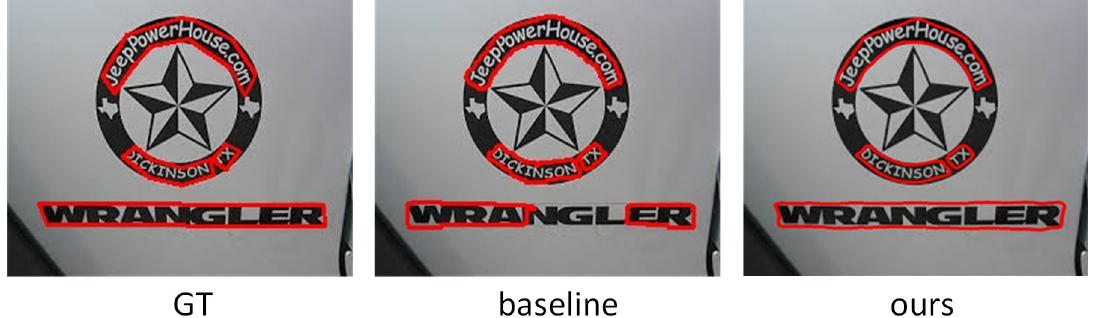
Fig 9. The visualization results of GT, baseline and our method on